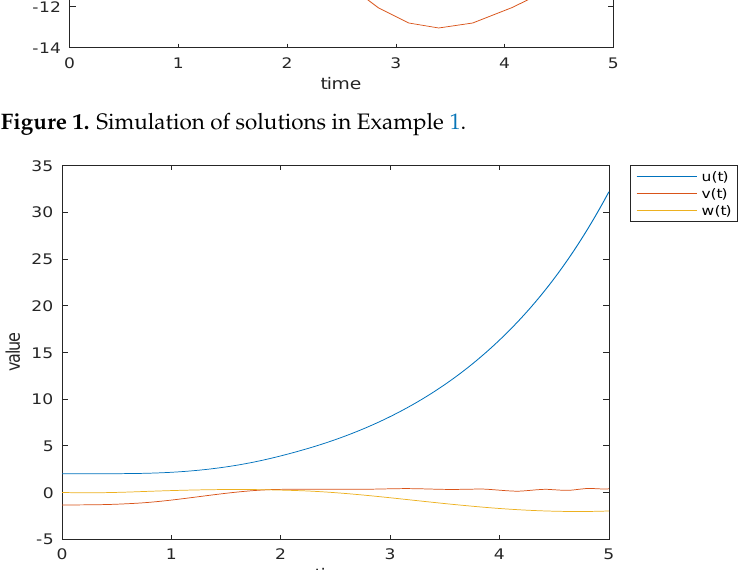
Figure 2. Simulation of solutions of the integer-order equation corresponding to Example 1. (b) When all parameter values remain invariant, the simulations of solutions of Example 2 and its corresponding integer-order differential equation are shown as Figures 3 and 4, respectively. u ( t ) is the solution of the Langevin equation in the figures. The comparison of numerical solutions of u ( t ) is given in Table 2. It can be seen from the simulation figures and table that the solution of the integer-order equation changes sharply, while the fractional-order equation changes gently.